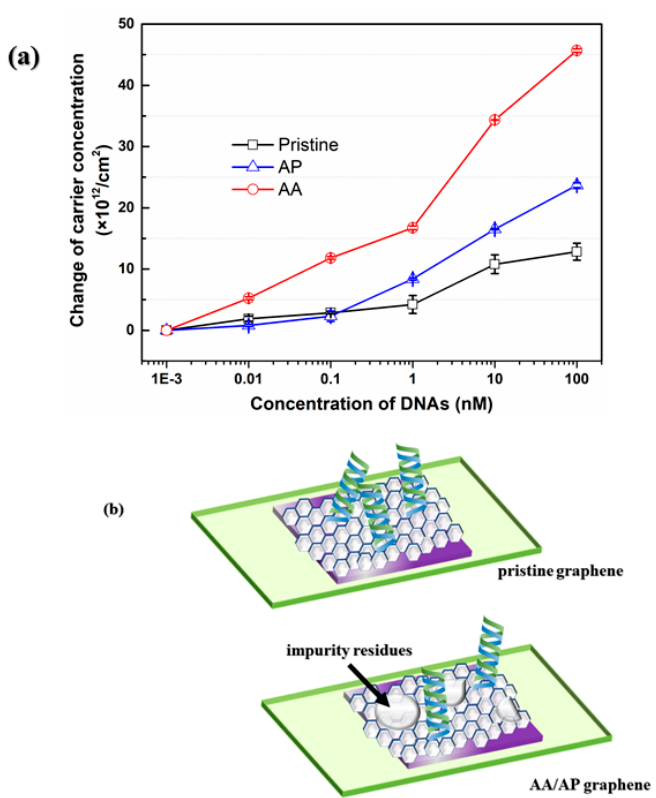
Figure 11. ( a ) The variation of carrier concentration of three kinds of graphene-based Hall effect devices as a function of added concentrations of target DNA; ( b ) the mechanism of higher sensitivity based on graphene with cleaner surface.